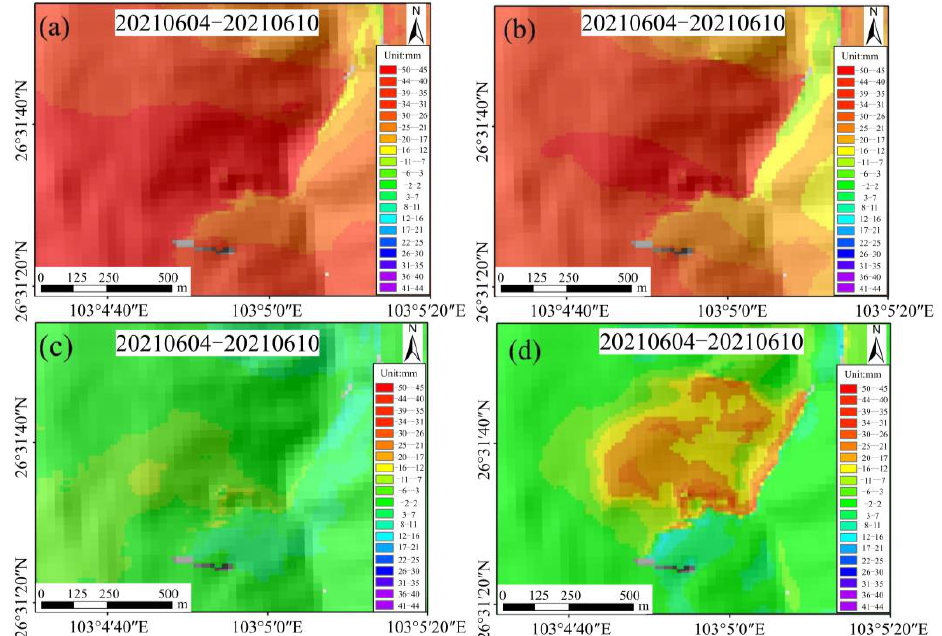
Figure 9. ( a ) Original displacement results; ( b ) displacement results after linear model correction; ( c ) displacement results after GACOS correction; ( d ) displacement results after correction of MLP neural network model.